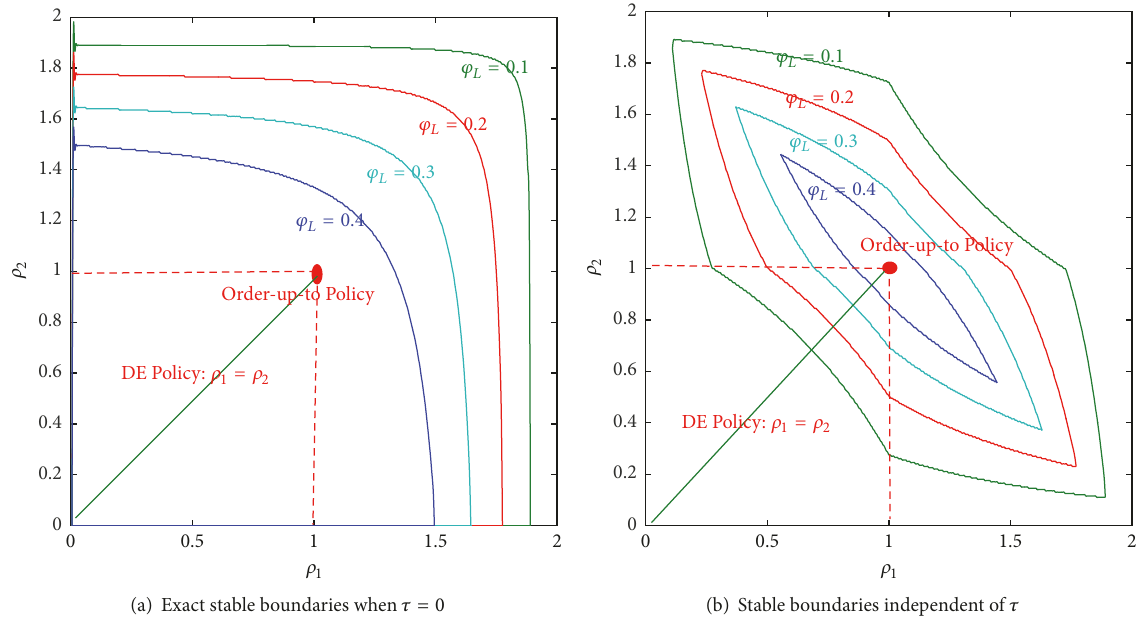
Figure 2: Stable boundaries in scenario 𝜉 1